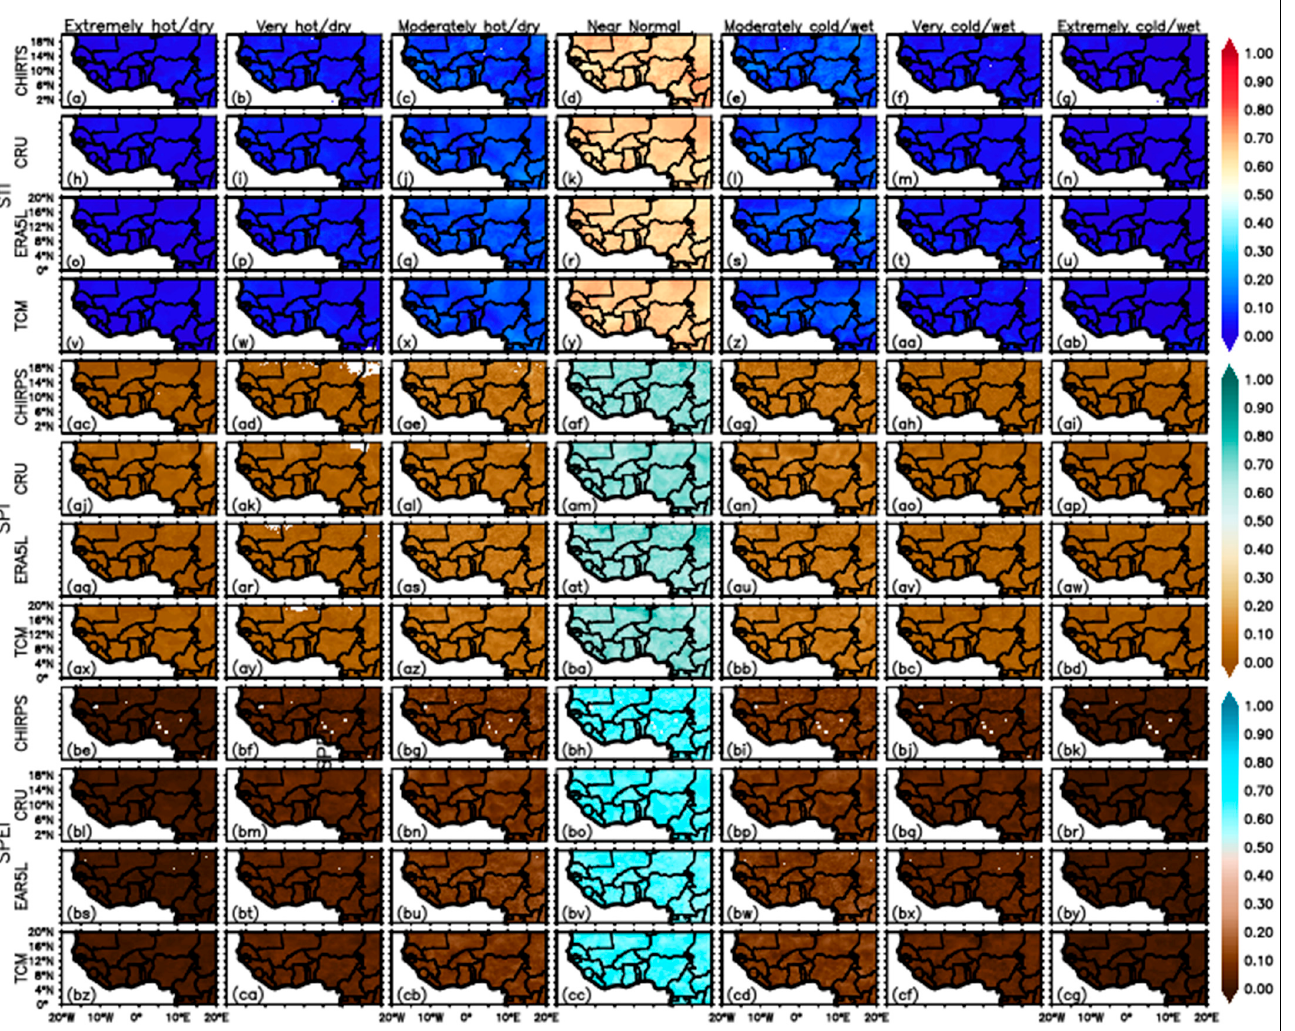
Figure 13. ( a – cg ) Probability of occurrence of various climatic conditions in West Africa.